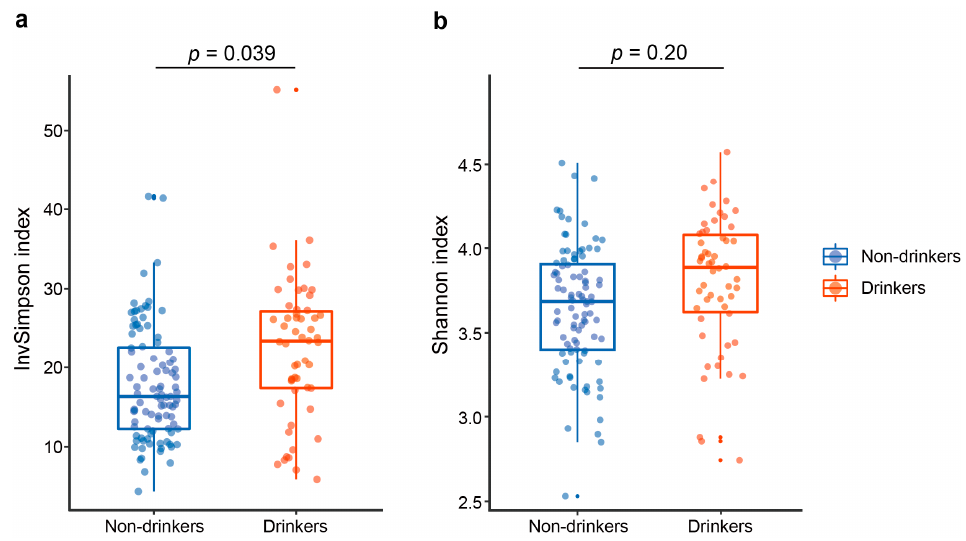
Figure 1. Alpha diversity estimates of the oral microbial community. Comparison of ( a ) InvSimpson index and ( b ) Shannon index in the oral microbiota between non-drinkers and drinkers. p values were calculated by the linear regression model.